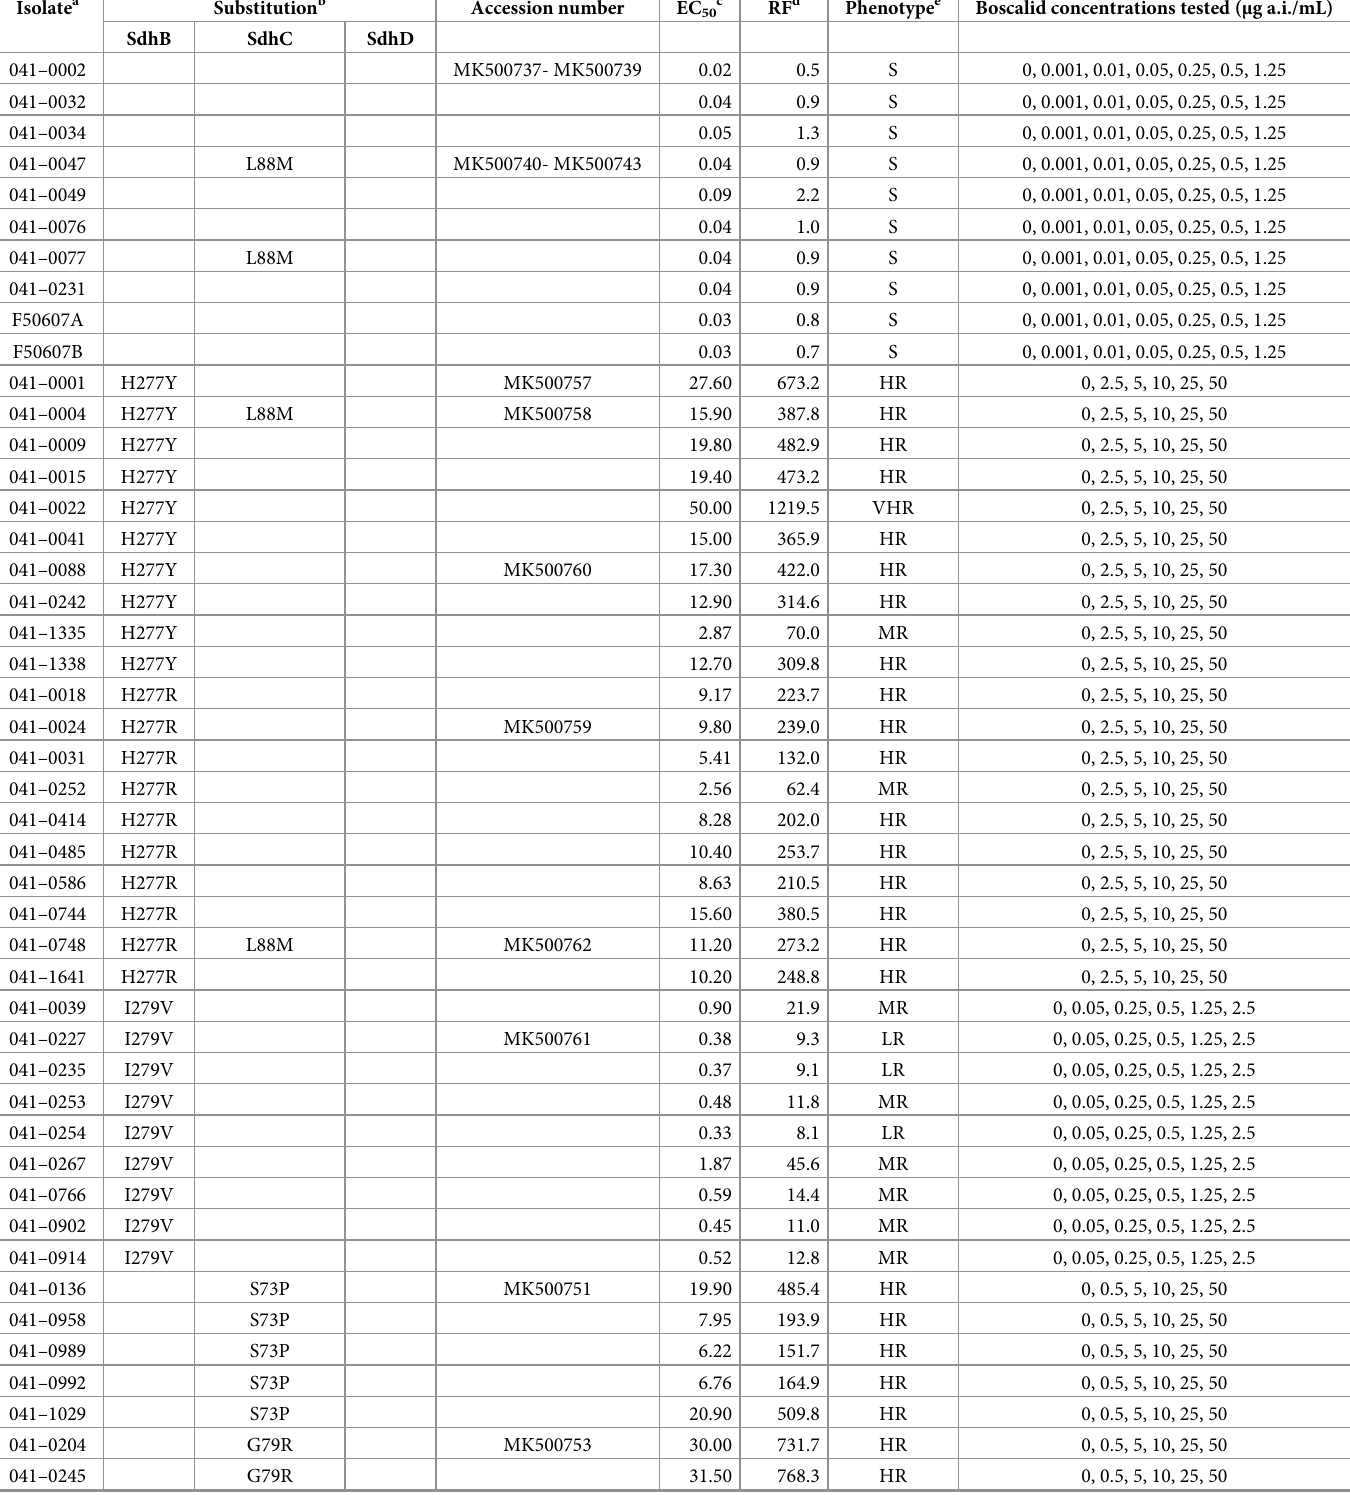
Table 1. EC 50 , resistance factor and associated phenotype of Didymella tanaceti isolates ( n = 92) with known SDH substitutions. Isolate